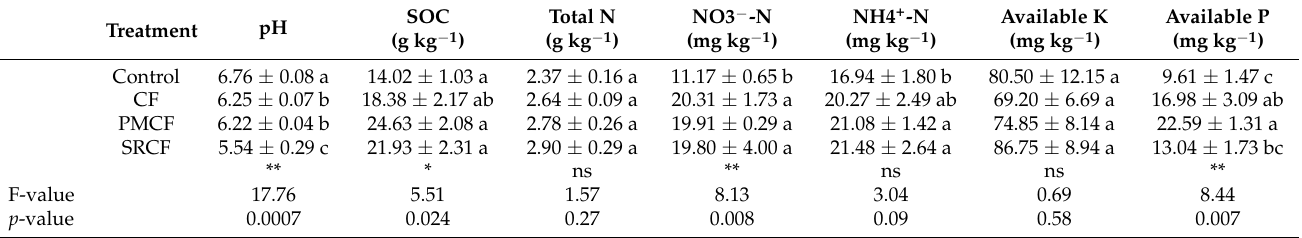
Table 1. Chemical properties of soils collected from long-term experiment plots of the unamended control (Control), chemical fertilizers (CF), pig manure plus chemical fertilizer (PMCF), and rice straw plus chemical fertilizer (SRCF). Values are mean + standard error of three